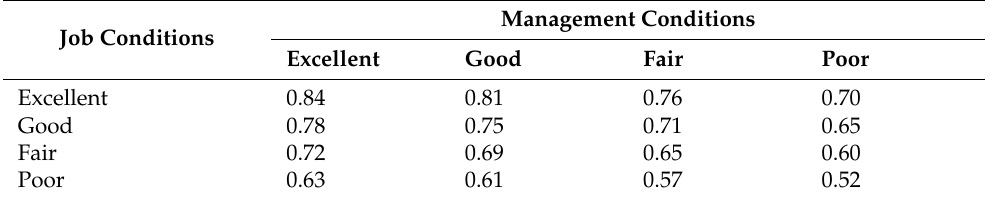
Table 3. Factors for job and management conditions [38].